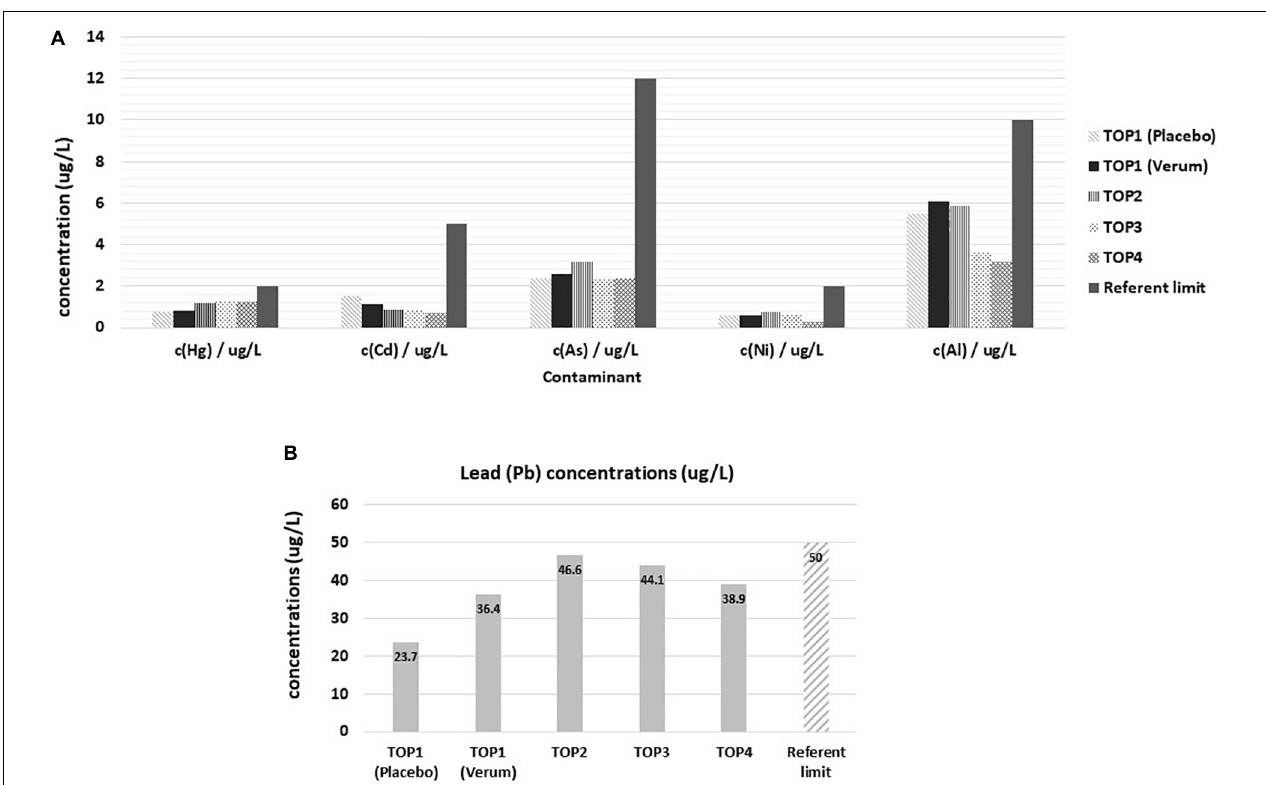
FIGURE 1 | Levels of contaminants in Placebo and Verum groups during the osteoporosis TOP study course of 4 years with corresponding reference limits. (A) Concentrations of mercury, cadmium, arsenic, nickel, and aluminum. Statistically lower values were observed in TOP4 in comparison with TOP3 for nickel ( post-hoc analysis, p < 0.001). (B) Concentrations of lead in the osteoporosis TOP study course of 4 years. Statistically lower levels of lead were observed in TOP4 comparison with TOP3 ( post-hoc analysis, p < 0.001). TOP1-Placebo (without PMA-zeolite supplementation); TOP1-Verum, end of the first year of PMA-zeolite supplementation; TOP2-Verum 2Y, end of the second year of PMA-zeolite supplementation; TOP3-Verum 3Y, end of the third year of PMA-zeolite supplementation; TOP4-Verum 4Y, end of the fourth year of PMA-zeolite